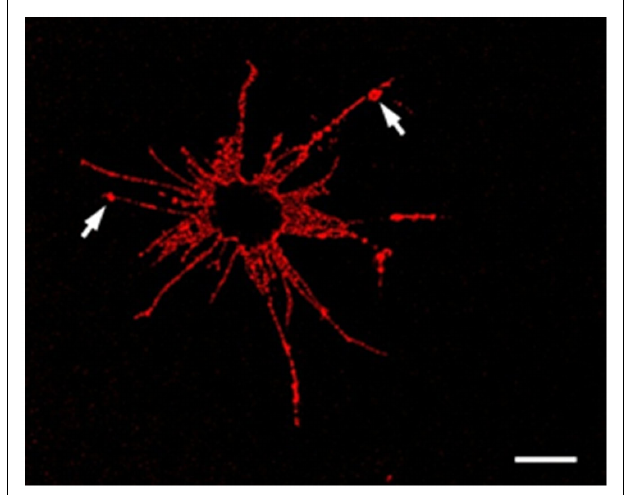
FIGURE 4 |An Sp185/333 + Small Phagocyte. Confocal image of a Sp185/333 + small phagocyte labeled with anti-Sp185/333 sera prior to fixation shows the filopodial morphology of the cell and indicates the presence of Sp185/333 proteins on the cell surface.This includes knobs on the filopodia that are strongly positive for Sp185/333 (arrows).The dark area in the center of the cell is the location of the nucleus. Bar = 10 μ m.This is Figure 5B reproduced from Brockton et al. (2008).